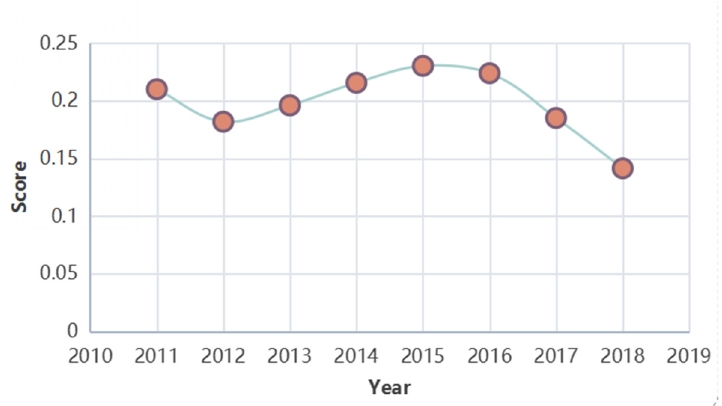
Figure 5. Trend of annual average efficiency.